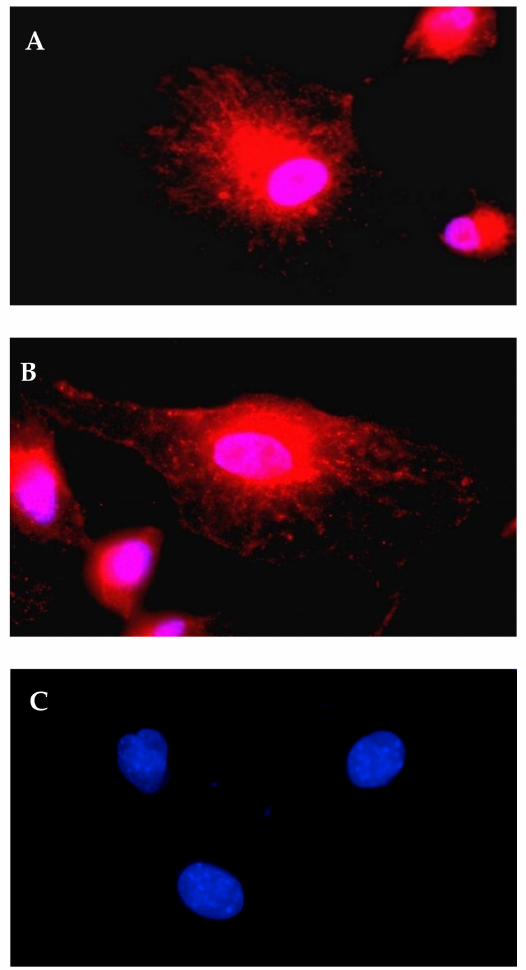
Figure 4. Intracellular A1AT visualized by immunofluorescence. ( A , B ) are representative pictures of A1AT-mRNA-transfected cells obtained from different fields. ( C ) Control of non-transfected cells. A total of 4.8 µ L Lipofectamine2000 was mixed with 6 µ L A1AT-mRNA (0.1 µ g/ µ L) in OptiMEM. 16HBE cells were incubated with the complexes for 2 h. Brefeldin-A was used to prevent the protein secretion. Pictures were taken 24 h after transfection using an Axiovert fluorescence microscope with 100 × magnification. Red fluorescence represents A1AT; blue or pink areas were cell nuclei-stained by